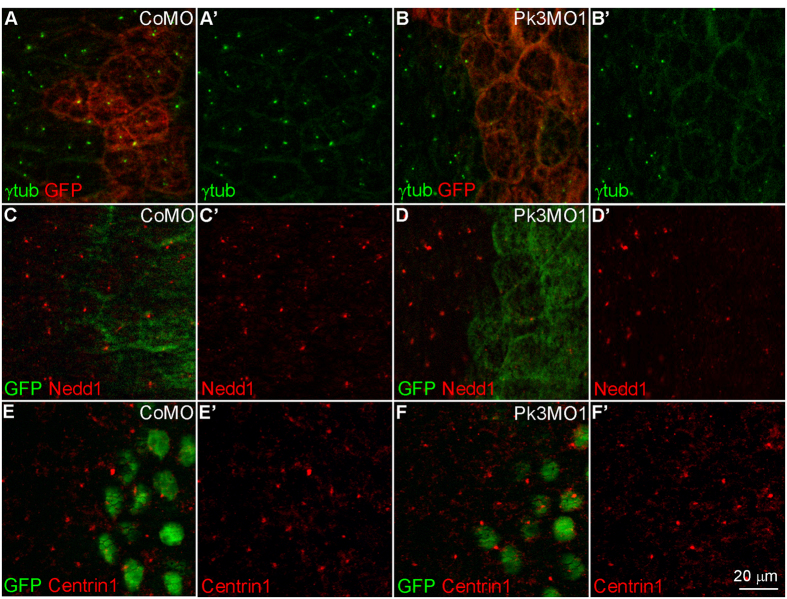
Pk3 depletion prevents γ-tubulin and Nedd1 recruitment to the basal body.Embryos were injected with 0.2 ng of RNA encoding GFP (A–D) or Histone-GFP (E,F) as a lineage tracer and CoMO (A,C,E) or Pk3MO1 (B,D,F) (15 ng each). GRP explants from stage 17 embryos were double stained for GFP and γ-tubulin (A,B), Nedd1 (C,D) or Centrin1 (E,F). En face staining is shown, anterior is at the top. Representative images from three to five independent experiments are shown, with 6–10 explants examined per group. The effects of Pk3MO1 on γ-tubulin and Nedd1 are detectable in the majority of cells depleted of Pk3 (n > 100).